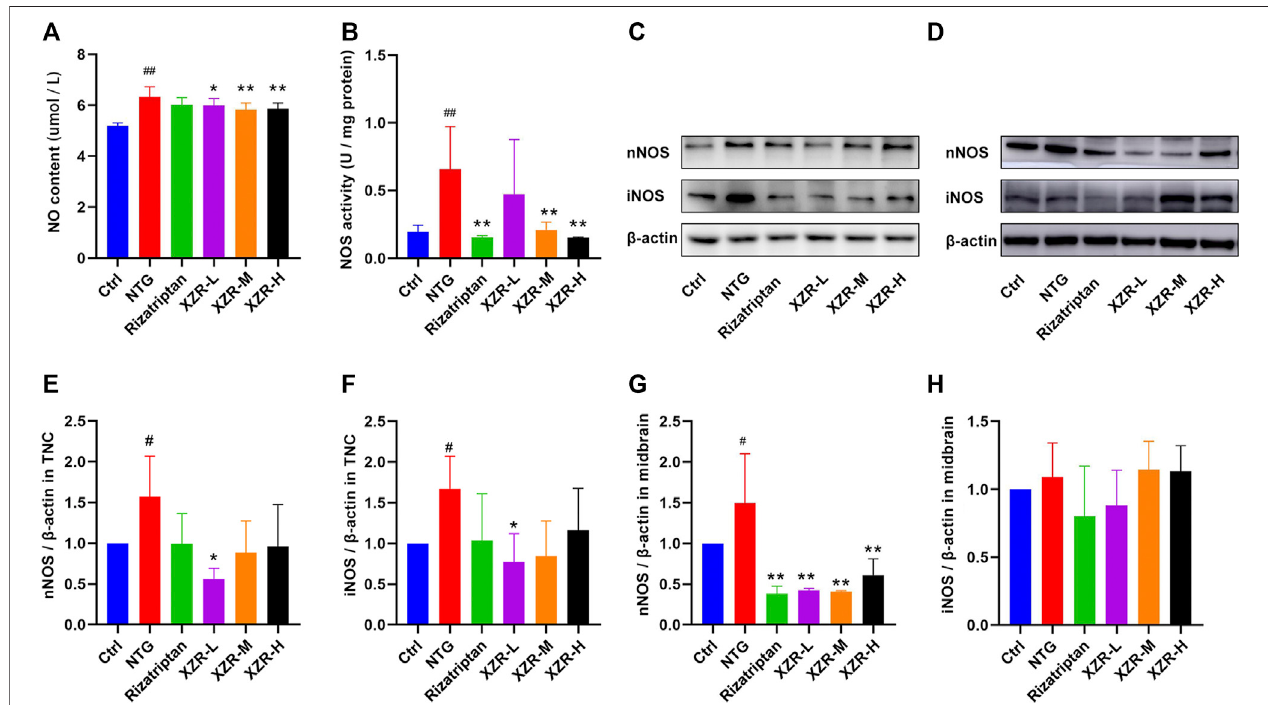
FIGURE 5 | XZR inhibited the NOS-mediated production of NO in rats with NTG-induced migraine. (A) NO level and (B) NOS activity in midbrain, n = 6. (C,D) Relative expression levels of nNOS and iNOS in the TNC and midbrain were determined by Western blotting. (E,F) Relative expression levels of nNOS and iNOS in the TNC. (G,H) Relative expression levels of nNOS and iNOS in the midbrain. Data are presented as the mean ± standard deviation, n = 3. # p < 0.05, ## p < 0.01 versus control group, * p < 0.05, ** p < 0.01 versus the NTG group. XZR, Xiongshao Zhitong Recipe; TNC, trigeminal nucleus caudalis; NTG,